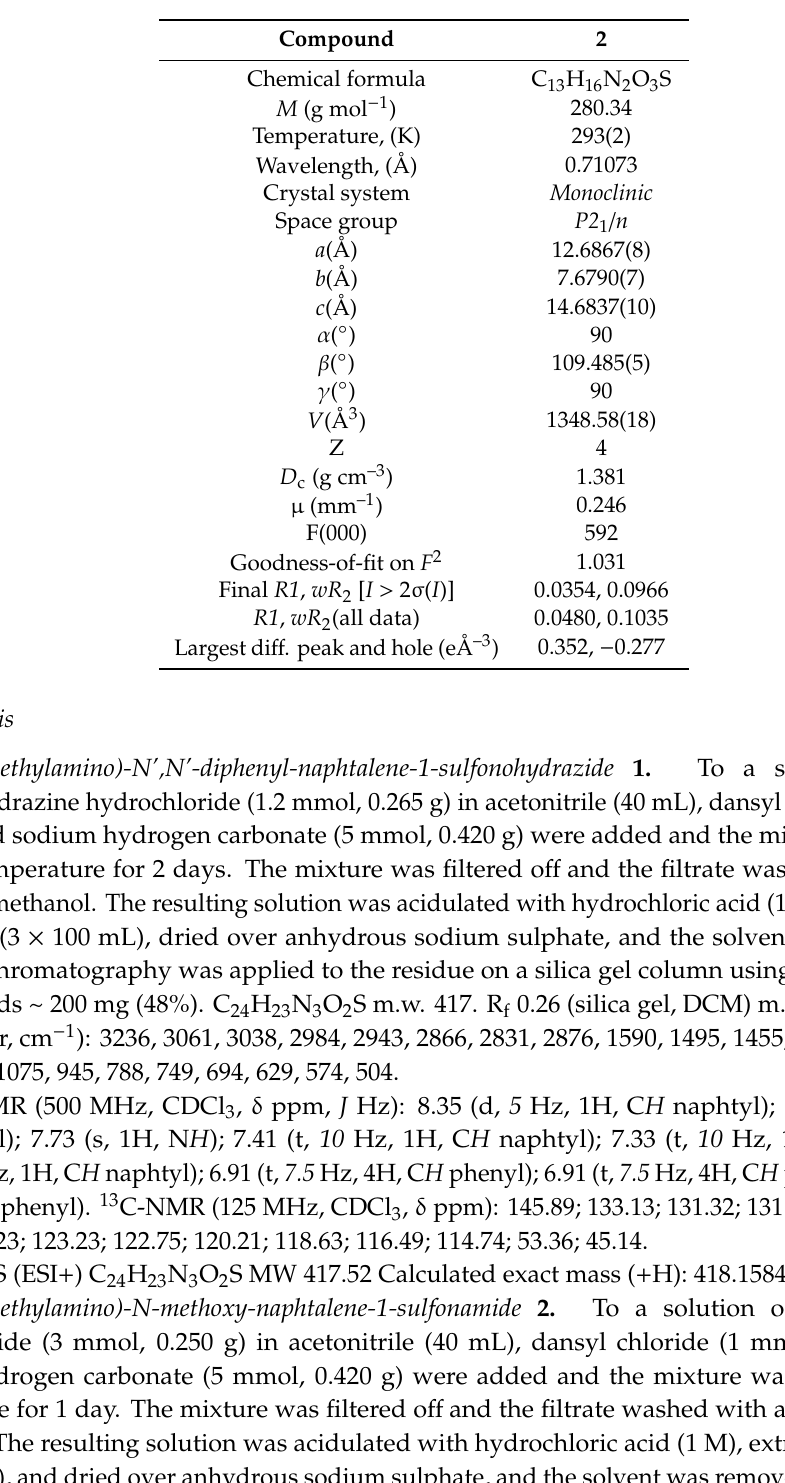
Table 2. Crystallographic data and details of data collection and structure refinement parameters for compound